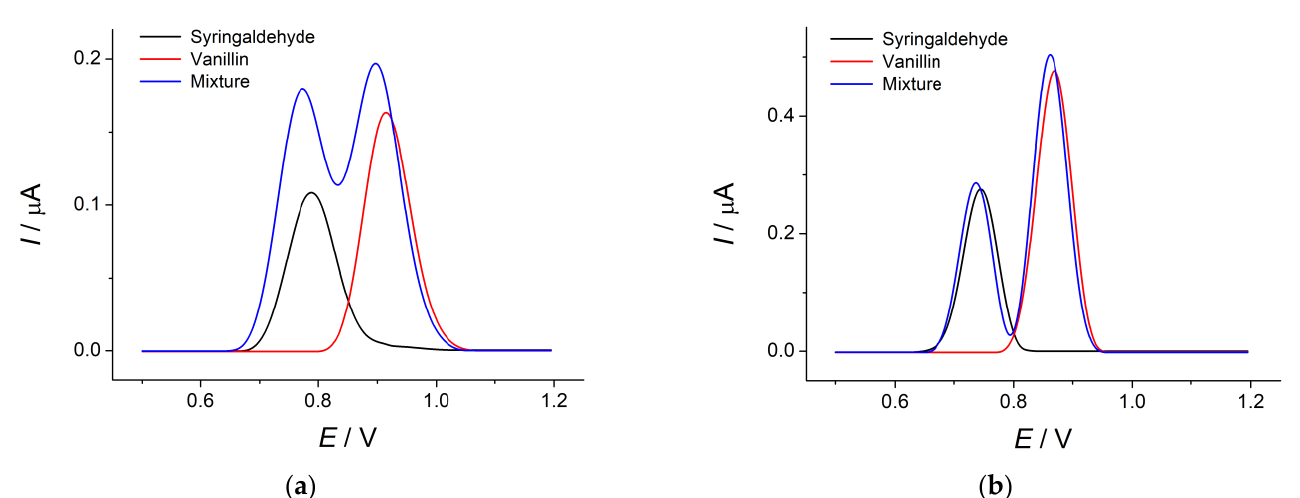
Figure 1. Baseline-corrected differential pulse voltammograms of 10 µM syringaldehyde, vanillin, and their mixture: ( a ) at the bare GCE; ( b ) at the MWCNTs/GCE. The supporting electrolyte is Britton–Robinson buffer pH 2.0. Pulse amplitude is 50 mV, pulse time is 50 ms, and potential scan rate is 10 mV · s − 1